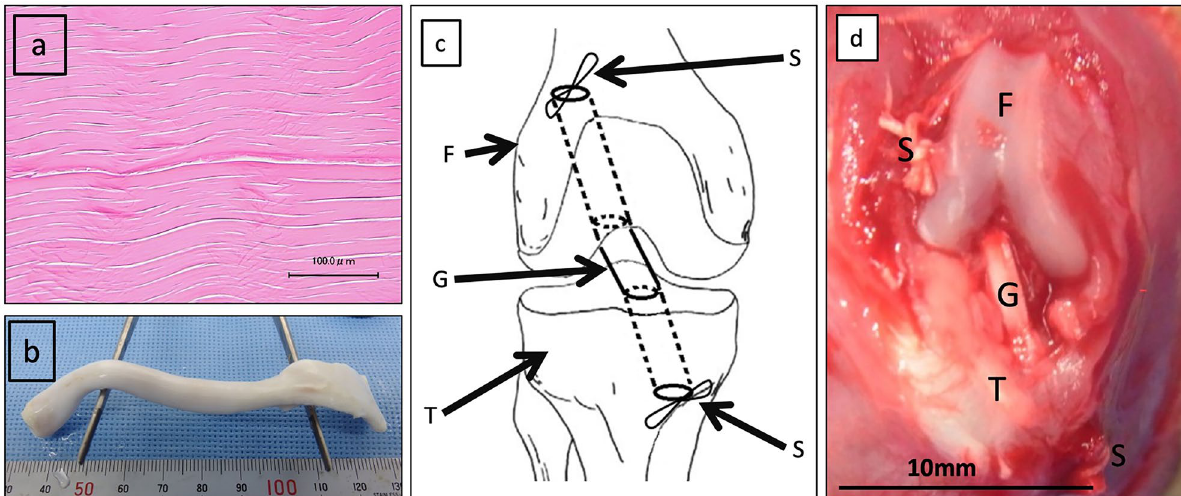
Figure 6. Anterior cruciate ligament reconstruction in rats using decellularized bovine tendon and autologous tendon grafts. ( a ) Hematoxylin–eosin staining of the decellularized bovine tendon. No cell components were observed, and the extracellular matrix and fiber arrangement were preserved. ( b ) The gross appearance of the decellularized bovine tendon after rehydration with physiological saline solution. ( c ) Schematic diagram of the completion of anterior cruciate ligament reconstruction in a rat. ( d ) Gross appearance of anterior cruciate ligament reconstruction in the right knee of the rat at completion. F femur, T tibia, G graft, S 3-0 silk